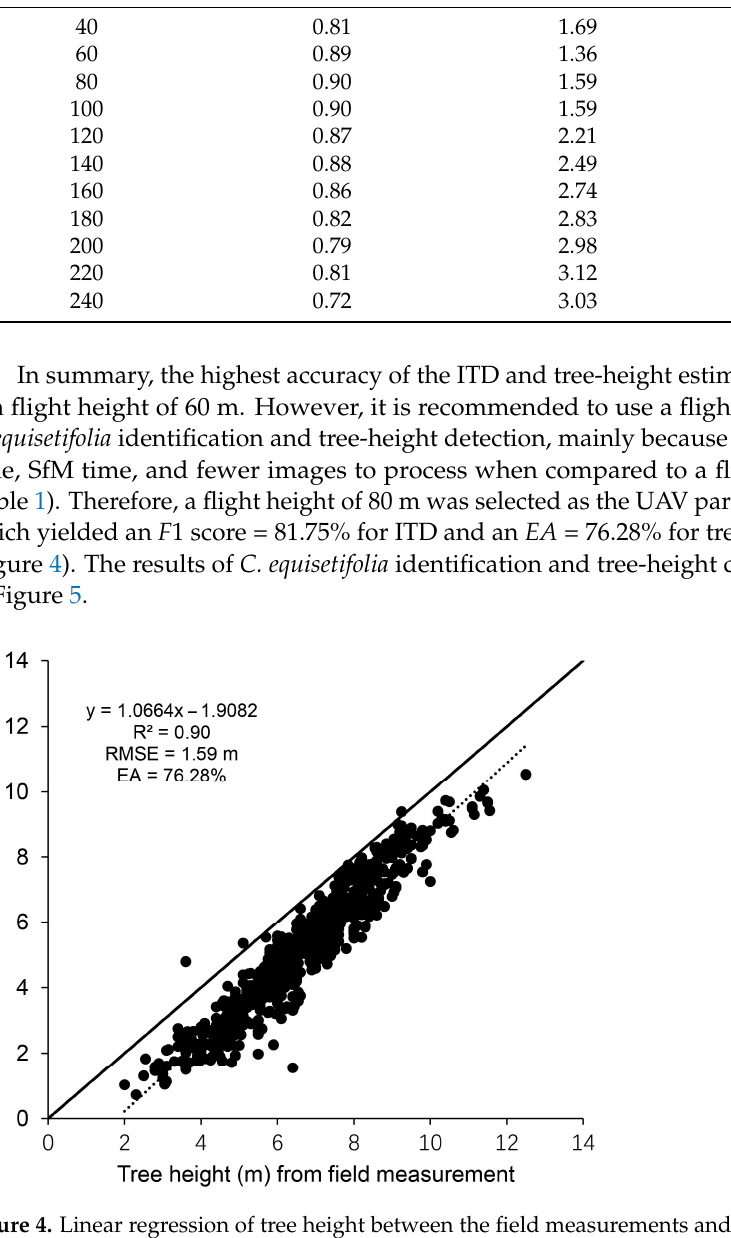
Figure 4. Linear regression of tree height between the field measurements and UAV imagery estimation at a flight height of 80 m.